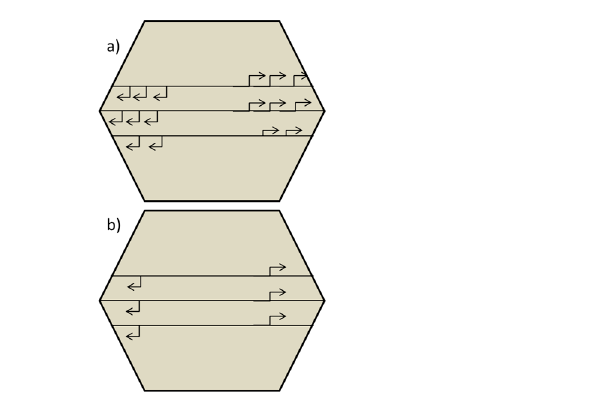
Figure 10. Breakdown of pile up mechanism: ( a ) microcrystalline level and ( b ) nanocrystalline level.